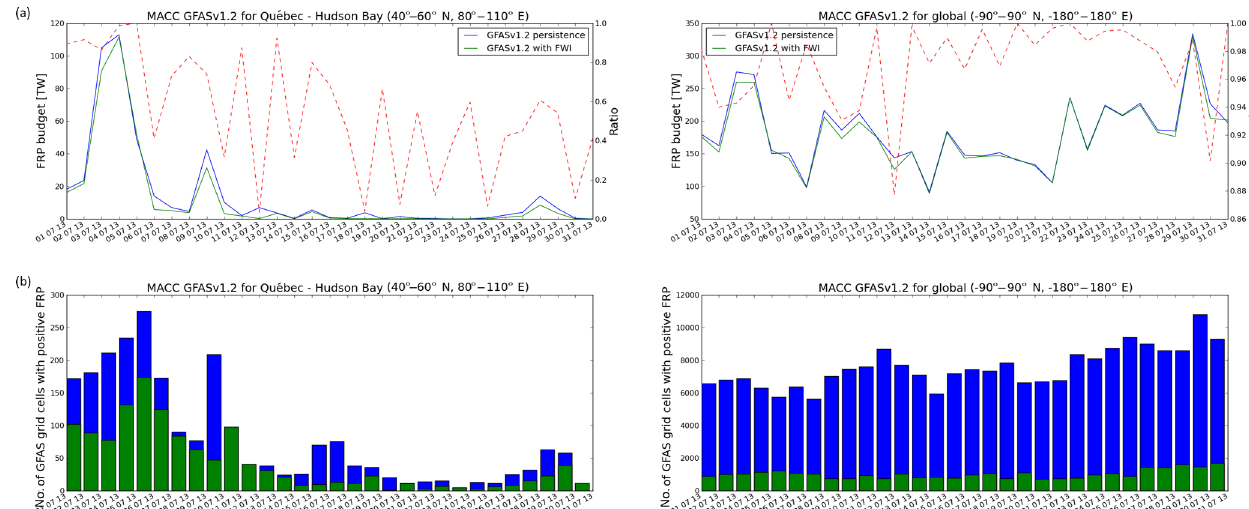
Figure 3. Budget of FRP over the Hudson Bay area and globally (a) . The GFAS using persistence as an observation operator is shown in blue and using FWI as an observation operator in green. The ratio between the two methods is indicated by the dashed red line. The histogram (b) shows the number of GFAS grid cells with positive observations for every day in July over the selected areas (blue bars) and among these the number of grid cells for which observational data were not available and FRP was estimated using either the persistence or the FWI-based model (green